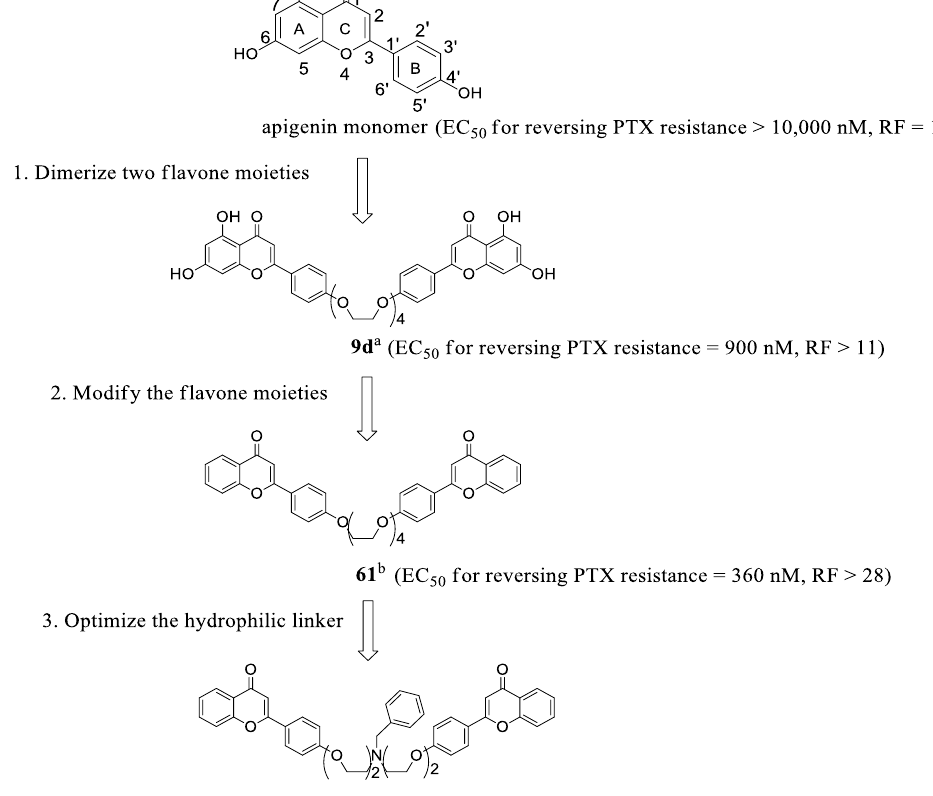
Figure 1. Chemical structures and P-gp modulating activities of different generations of synthetic flavonoids. Three generations of synthetic dimeric flavonoids were designed and synthesized to reverse P-gp-mediated MDR. EC 50 was the effective concentration of a modulator at which the IC 50 of an anticancer drug can be reduced by half in the cancer cell line. RF (relative-fold) was the ratio of EC 50 of apigenin to EC 50 of different synthetic flavonoids. a Structure and EC 50 of apigenin and 9d had been reported in 2006 [21]. b Structure and EC 50 of 61 had been reported in 2009 (Reprinted/adapted with permission from ref. [22], copyright © 2009 by WILEY-VCH Verlag GmbH & Co. KGaA, Weinheim. c Structure and EC 50 of FD18 had been reported in 2012